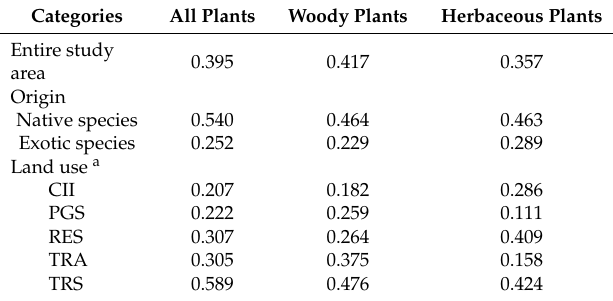
Table 6. Floristic dissimilarity ( β sim ) between the built-up area (BUA) and the urban planning area (UPA) grouped by all plant species, native status, vegetation types, and land